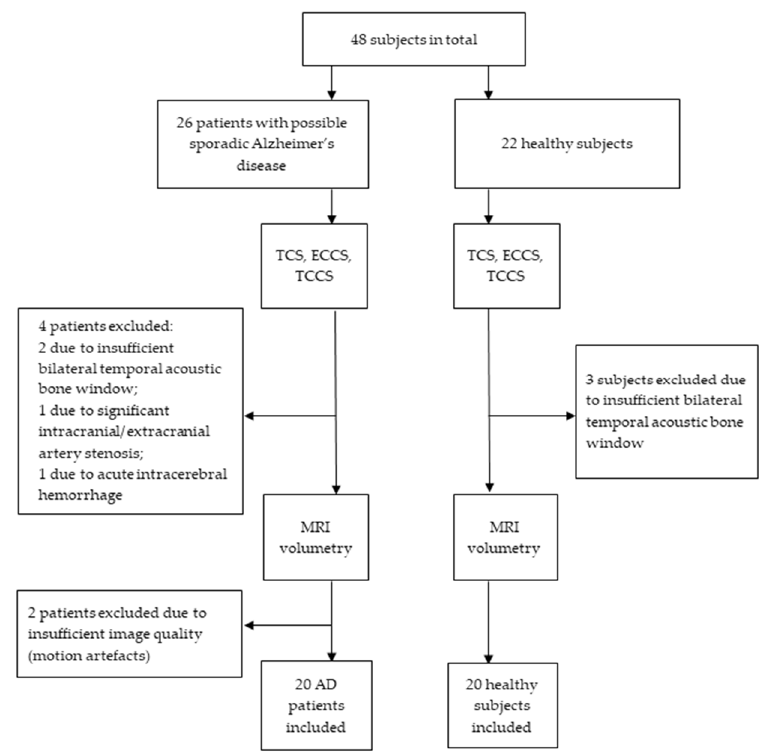
Figure 1. Study recruitment profile. TCS—transcranial sonography; TCCS—transcranial color-coded duplex sonography; ECCS—extracranial color coded duplex sonography.